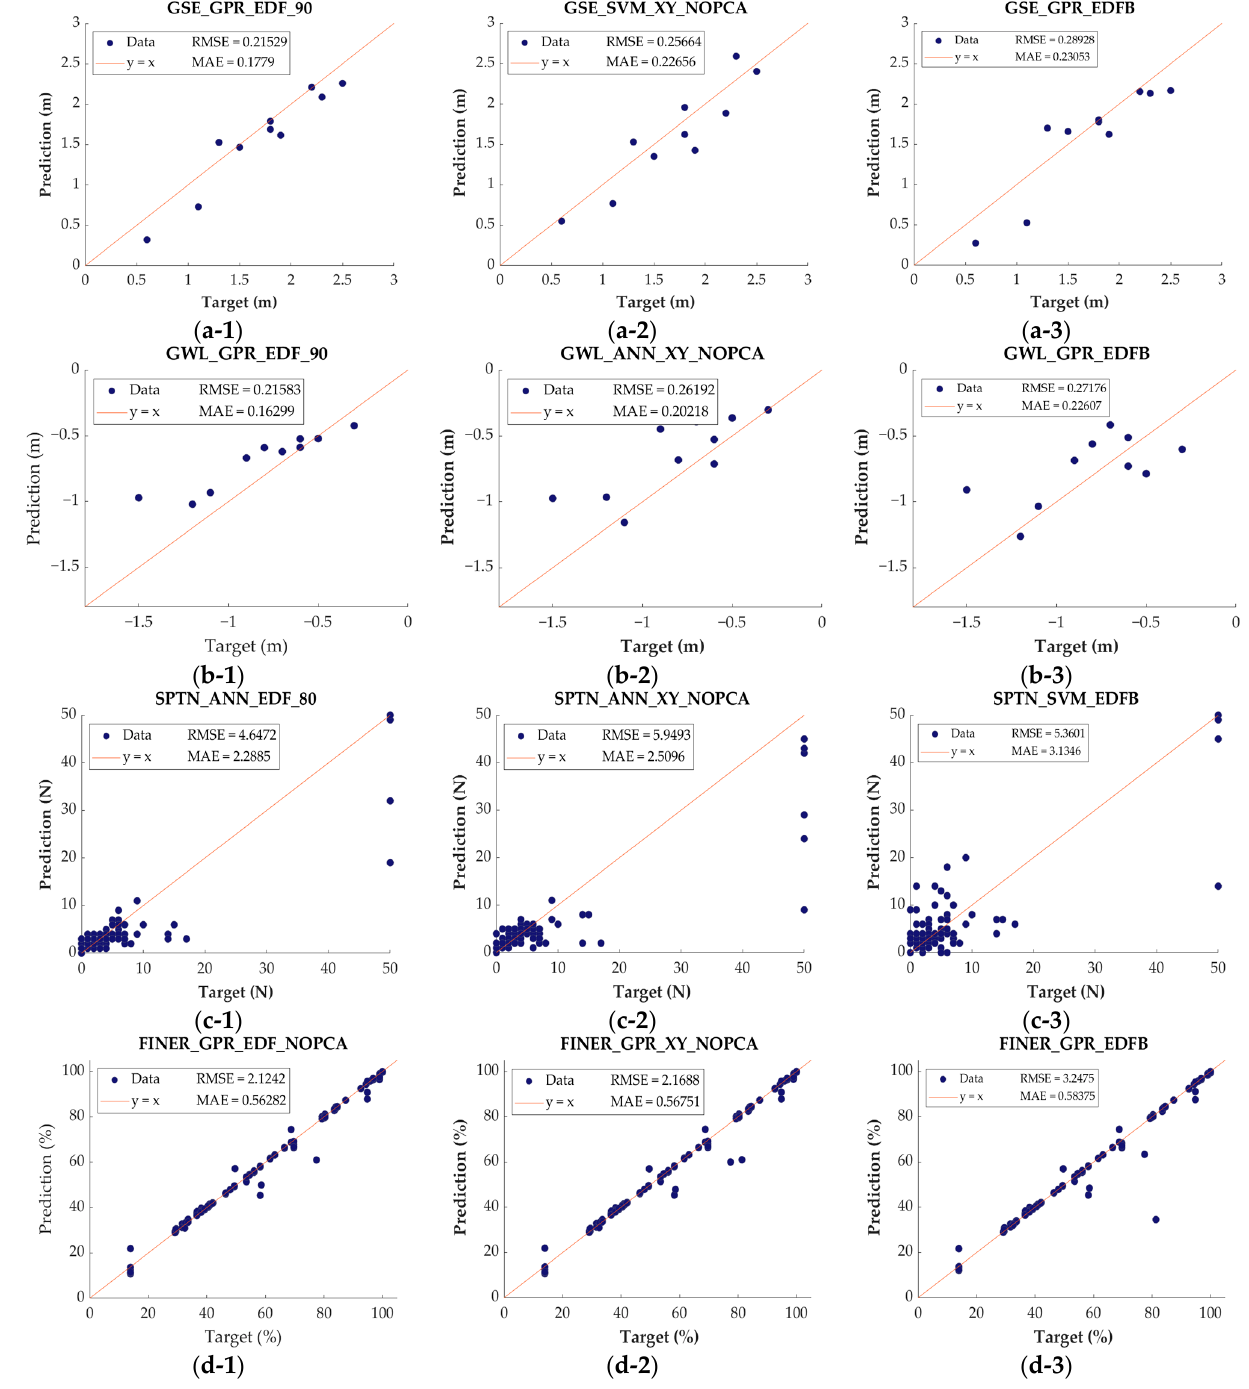
Figure 8. Comparison of the best-performing ( 1 ) EDF, ( 2 ) XY, and ( 3 ) EDFB machine learning model: ( a ) GSE; ( b ) GWL; ( c ) SPT-N value; and ( d ) % fi ner than 0.075 mm sieve.